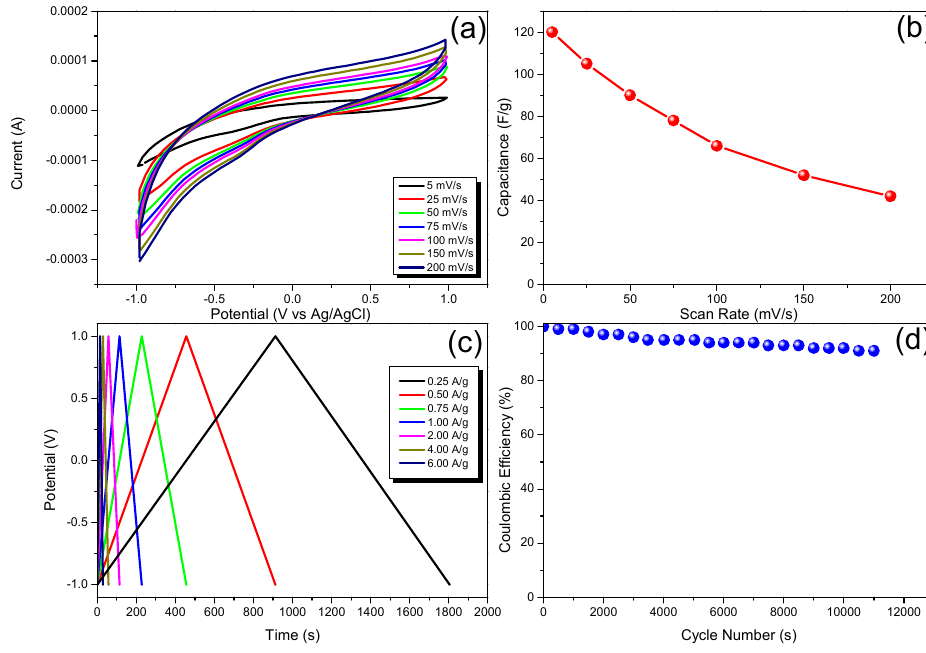
Figure 8. Mesoporous carbon from phenolic / LEL blend (60 / 40): ( a ) CV curves recorded at various scan rates; ( b ) capacitance plotted versus scan rate; ( c ) charge / discharge curves recorded at various current ranges; ( d ) coulombic efficiency recorded at 20 Ag − 1 for cycles.